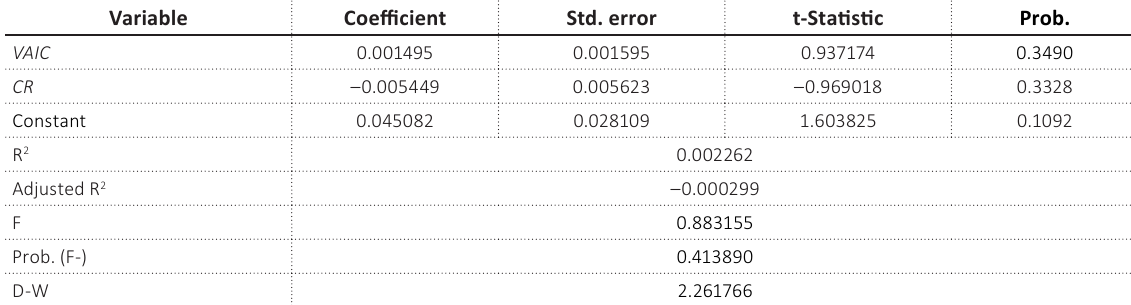
Table 8. Model 1